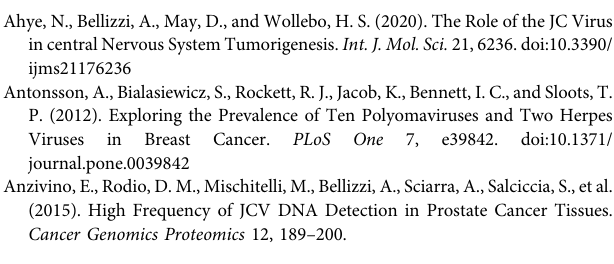
Frontiers in Molecular Biosciences |